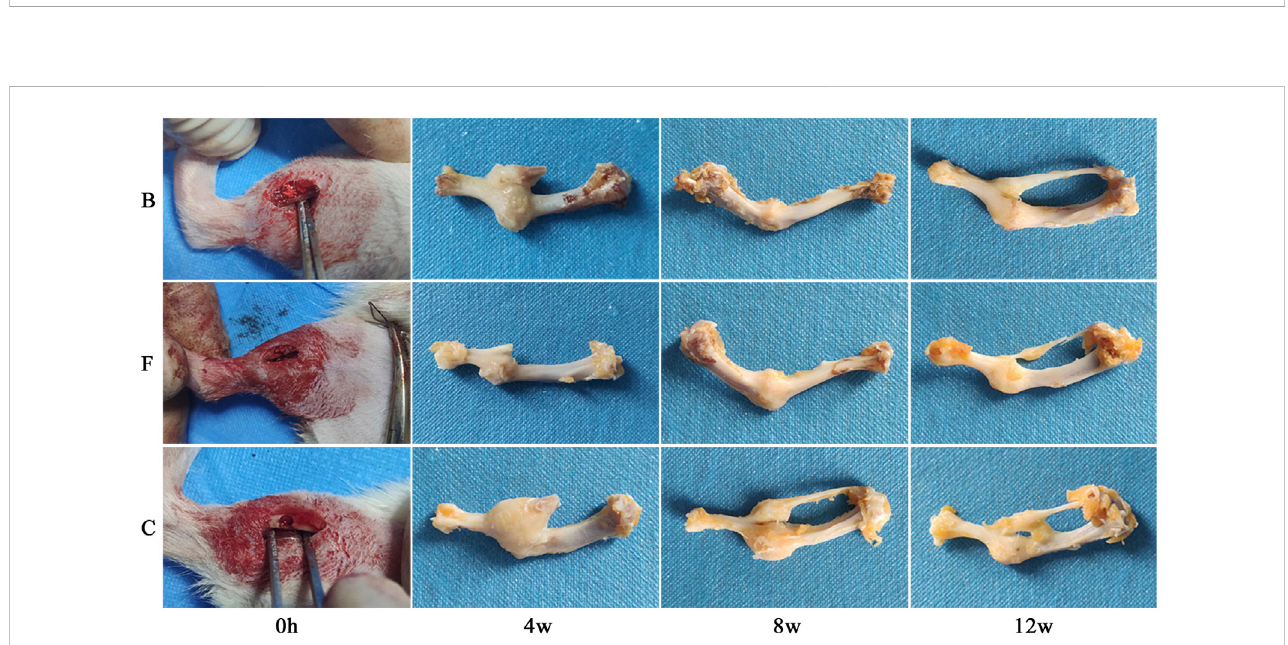
FIGURE 11 Effect of repairing femoral defect (B: BDBM group; F: FDBM group; C: Self-healing group).